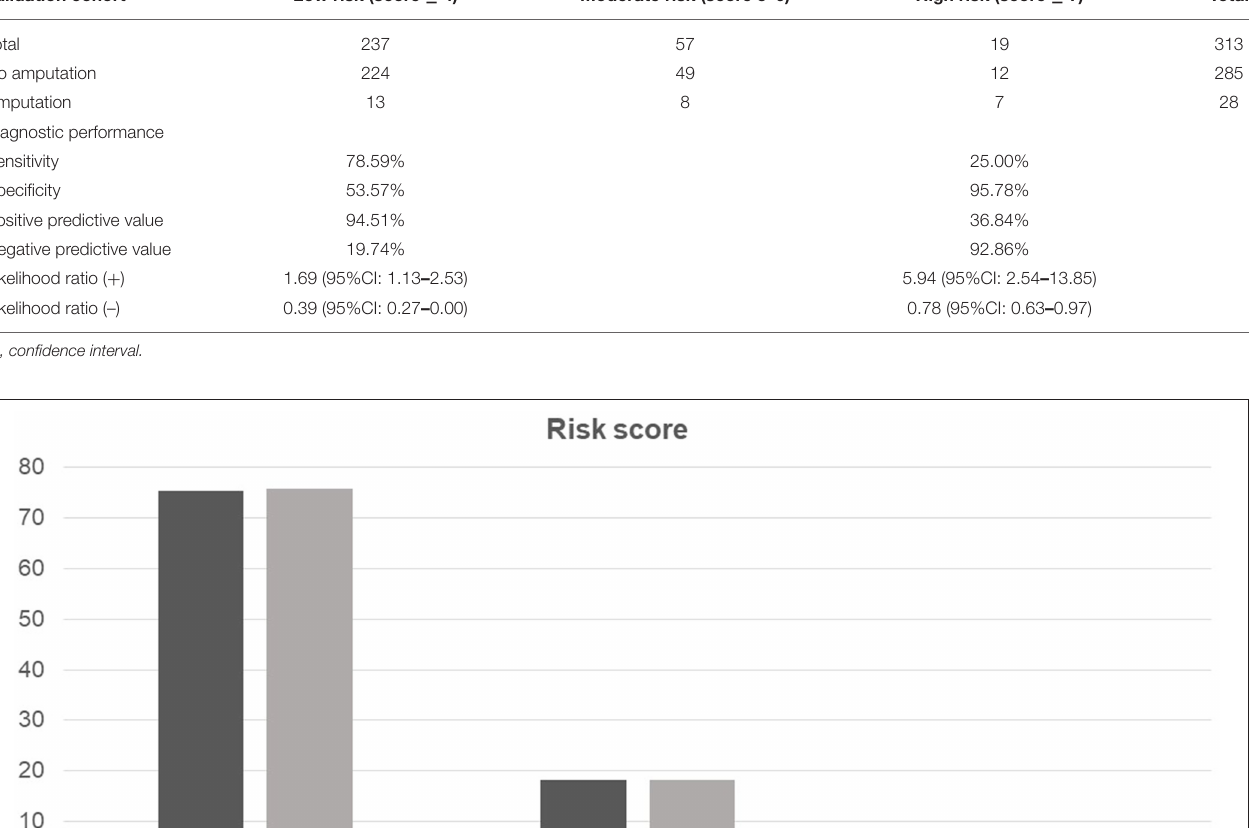
TABLE 5 | Distribution of risk of amputation in patients with necrotizing fasciitis, diagnostic performance, and interpretation in the validation cohort ( n = 313). Validation cohort